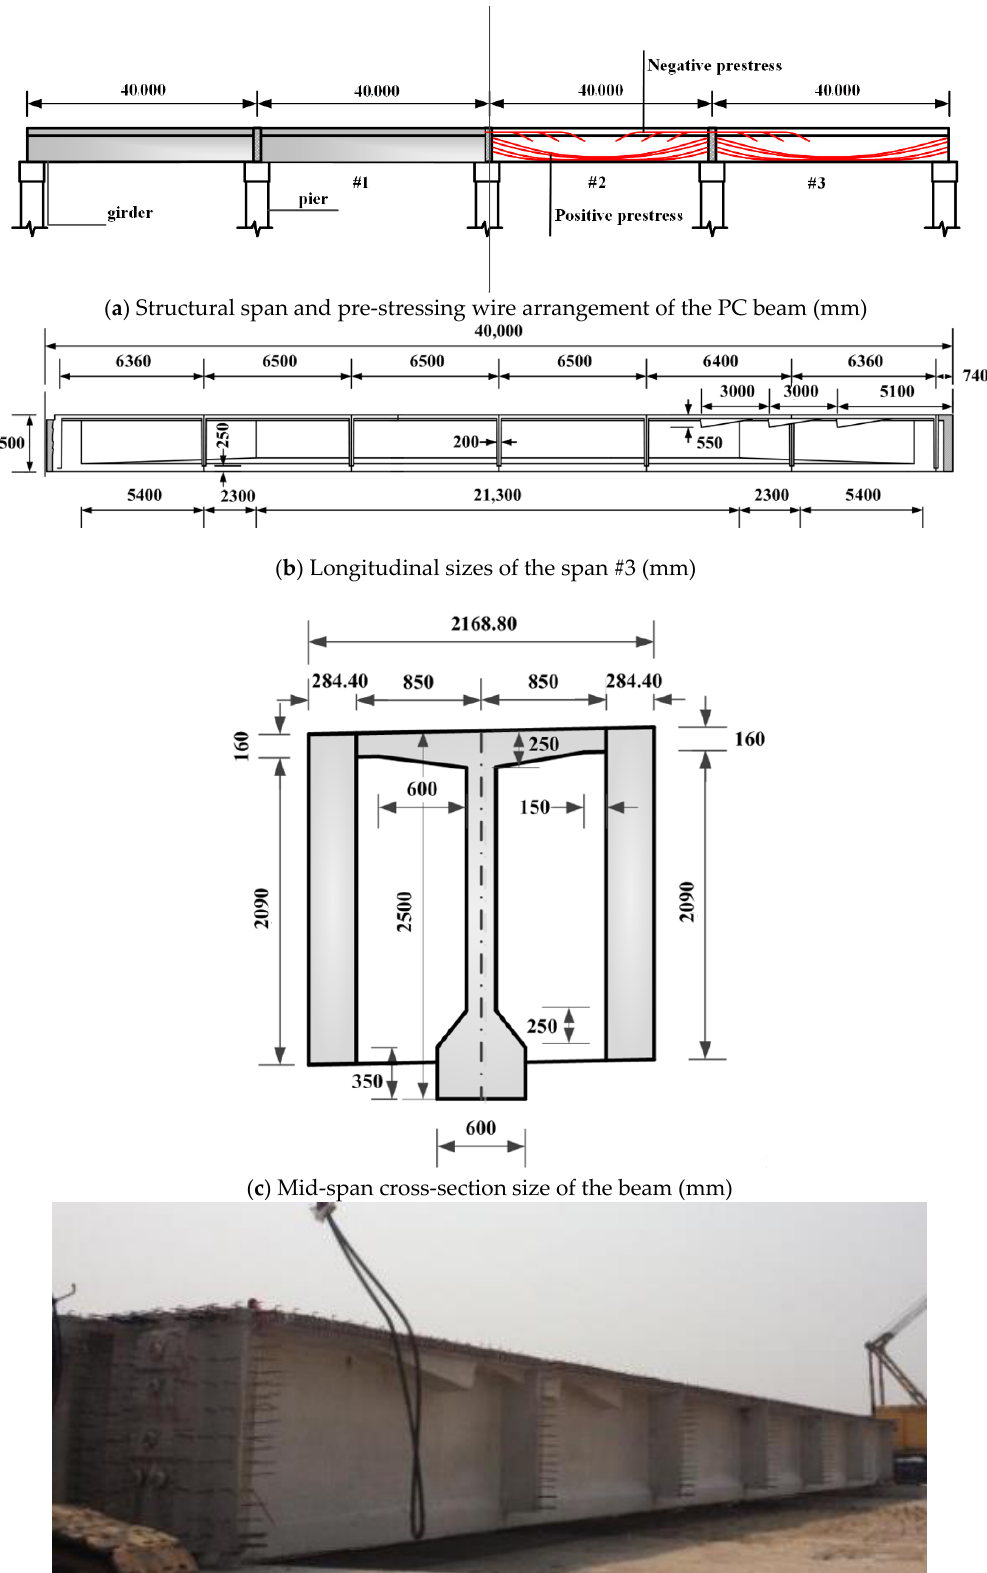
Figure 1. Dimensions of the PC beam.